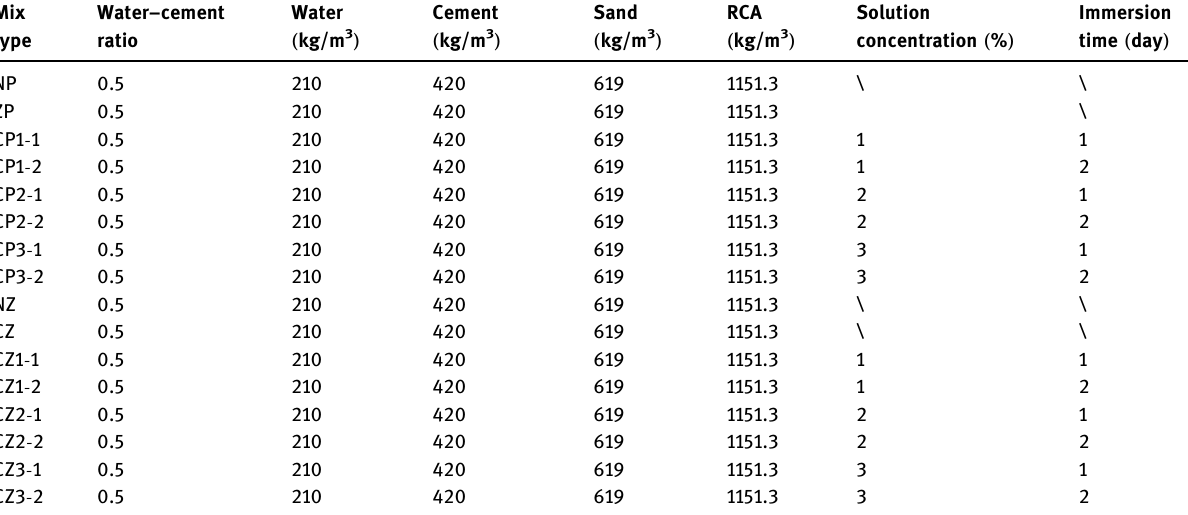
Table 3: Mix proportions of RAC